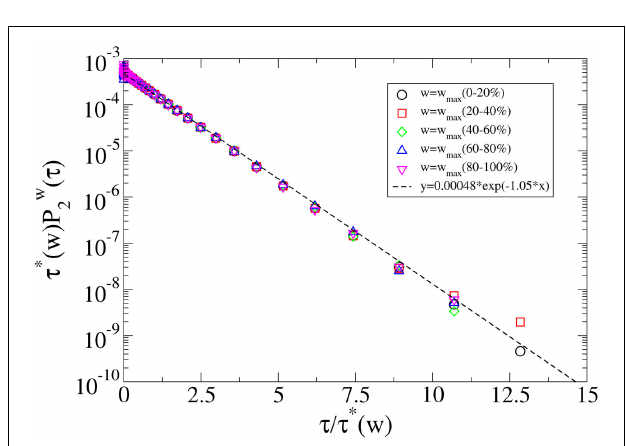
FIGURE 2 | Data collapse of the simulation of the proposed model for cell phone communication with β = 0. In the figure we plot the (τ) that in the model a pair of agents with strength w are probability P w 2 (τ) is described by the interacting for a period τ .The collapses data of P w 2 exponential distribution predicted theoretically and indicated by a solid line.